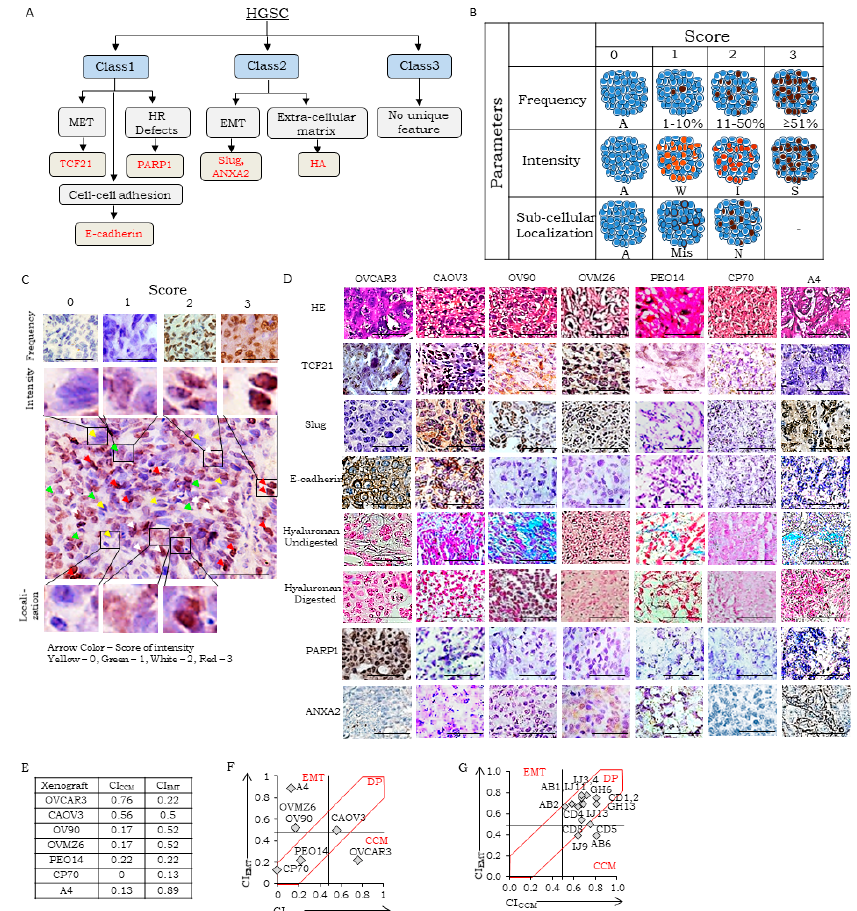
Figure 1. Class associations and marker scoring guidelines; ( A ) rationale for class-specific biological function based putative marker selection, MET: Mesenchymal-to-epithelial transition, HR: Homologous Recombination mediated DNA Damage Repair, EMT: Epithelial-to-mesenchymal transition; ( B ) schematic of scoring guidelines for IHC based staining of nuclear markers (TCF21, PARP1, Slug), A: Absent, W: Weak, I: Intermediate, S: Strong, Mis: Mislocalised, N: normal localization. A similar approach was used for scoring of membrane markers (E-cadherin, ANXA2) except that sub-cellular location was scored either 1 (cytoplasm) or 2 (cell membrane), while extracellular expression of hyaluronan fibers (evaluated as blue color developed by Alcian blue staining that is lost on hyaluronidase) was scored 1 in distant tumor stroma, and 2 in tumor epithelial cell nests. Scoring and analyses of marker expression in xenografts and TMAs; ( C ) Tissues and markers for Scoring of Frequency–0: A4 (TCF21), 1: OV90 (Slug), 2: OVCAR3 (PARP1), 3: A4 (Slug); scoring of intensity and localization-CAOV3 (TCF21), different regions representing scores of 0–3 (intensity) and 0–2 (localization), Scale bar is 50 μ m; ( D ) Representative micrographs of HGSC xenografts for: Row 1-H&E (hematoxylin and eosin) stained section while Rows 2,3,4,7,8 represent IHC-based identification of TCF21, Slug, E-cadherin, PARP1, and ANXA2; Rows 5 and 6 represent HC-based identification of HA fibers in untreated and hyaluronidase digested xenograft sections respectively, scale bar is 50 μ m; ( E ) class Indices of xenografts; ( F ) and ( G ) scatter plots of CI CCM vs. CI EMT in xenografts and high-grade serous ovarian carcinoma (HGSC) cases in TMA respectively. DP-double positive; CCM-cooperative cell migration.